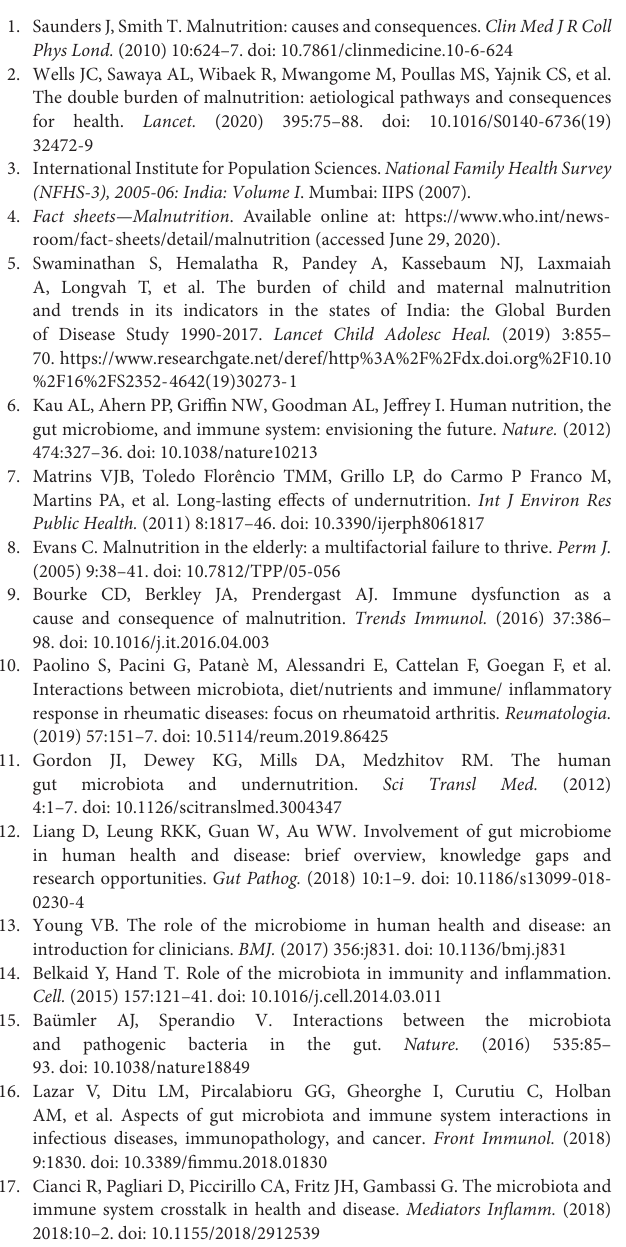
Supplementary Table 1 | Characteristics of the study participants based on the location (rural vs. urban slum). (A) Clinical Traits, (B) Bacterial phylum abundances expressed as relative abundance. The data is expressed as Mean (Standard Deviation). p -values are for independent sample t -tests. ∗∗ p -values significant at the level of ≤ 0.001; ∗ p -values significant at the level of < 0.05. Supplementary Table 2 | Abundances of taxa at the family level based on location (i.e., rural vs. urban slum). The data is expressed as Mean (Standard Deviation). p -values are for independent sample t -tests. ∗∗ p -values significant at the level of ≤ 0.001; ∗ p -values significant at the level of <